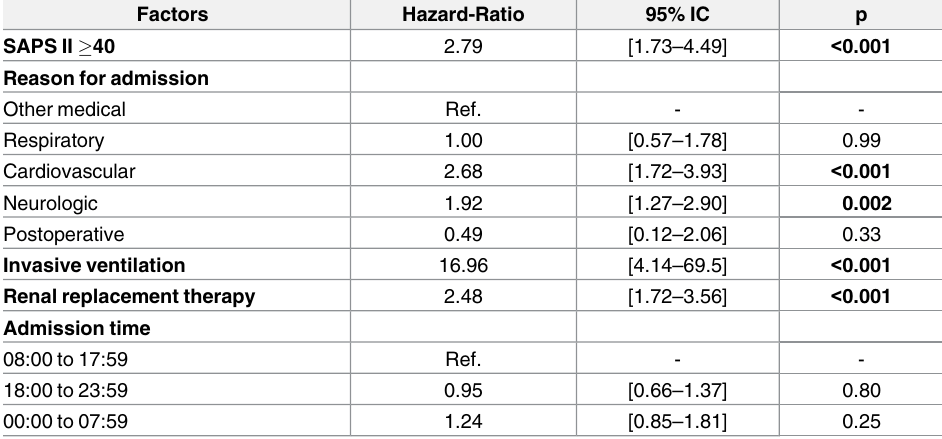
Table 6. Multivariate Cox model of factors associated with ICU mortality. Included variablesin the anal- ysis: age, sex, BMI, SAPS II, nutritionalstatus, admissionsource, hospital admissioncategory, reasonfor admission,life support